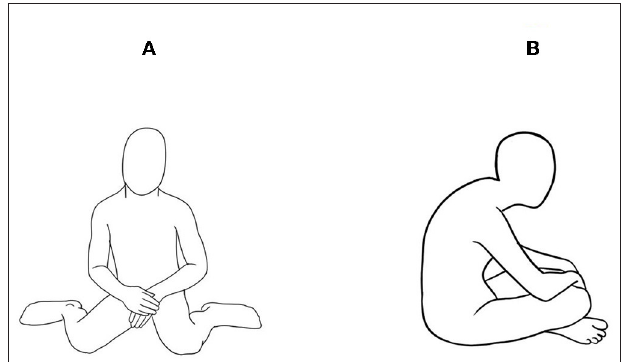
FIGURE 1 | Illustration of the seated in “W” position (A) and concave seated position (B) .